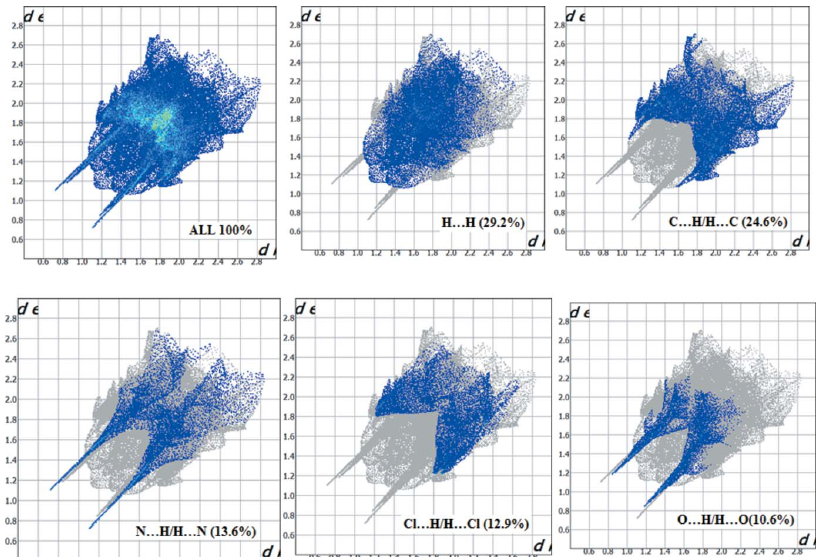
Figure 7 The 2D fingerprint plots for the title compound.